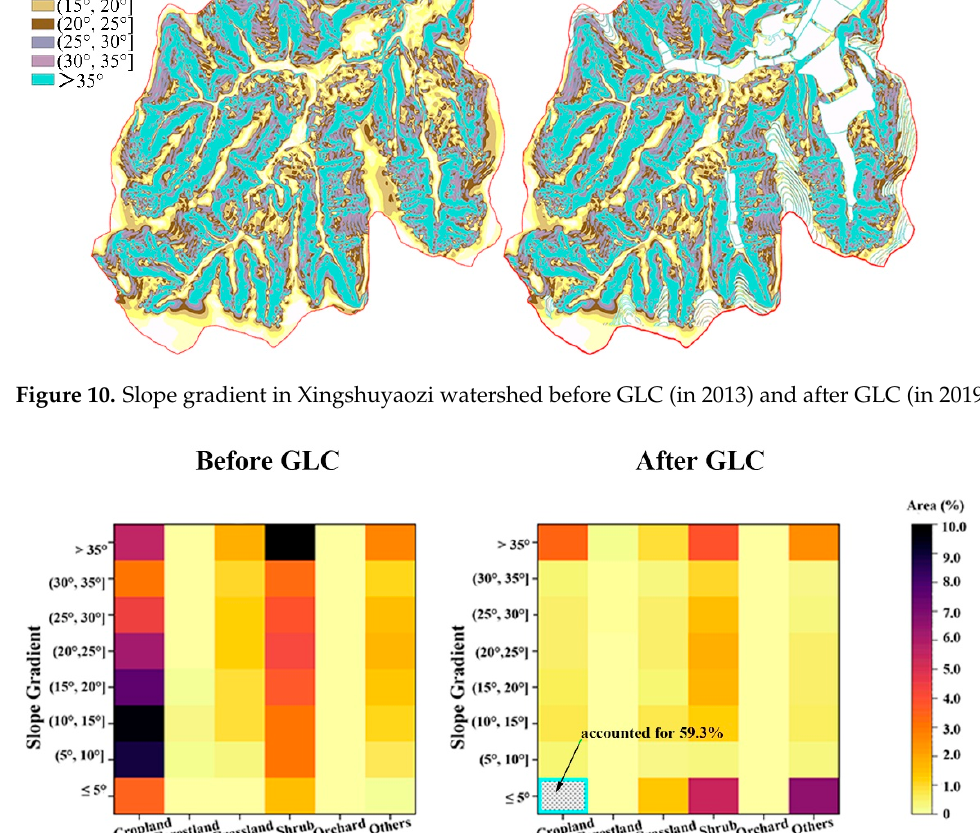
Table 7. Surface runoff in different land use types.